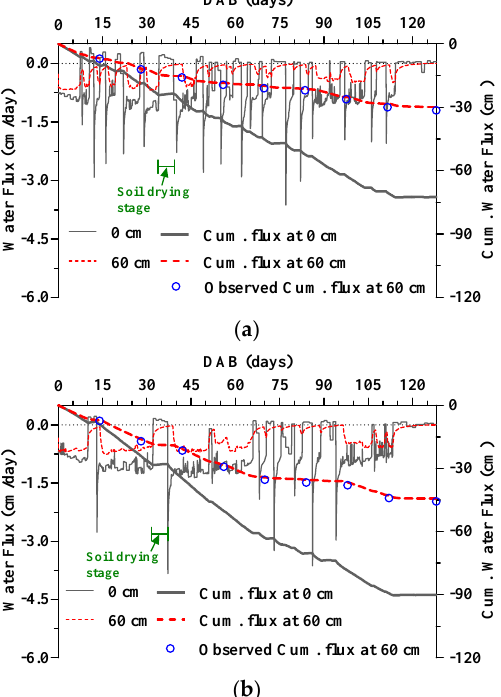
Figure 6. Observed (points) and simulated (lines) water fluxes at the soil surface and at a depth of 60 cm during the 2008 ( a ) and 2009 ( b ) seasons.